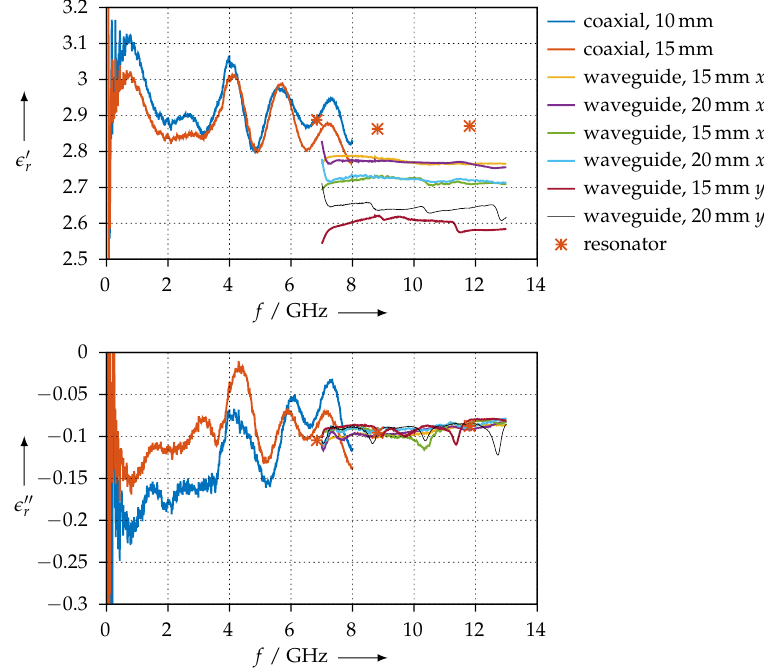
Figure 26. Real ( (cid:101) (cid:48) r ) and imaginary ( (cid:101) (cid:48)(cid:48) r ) parts of the permittivity for the KIM material for different